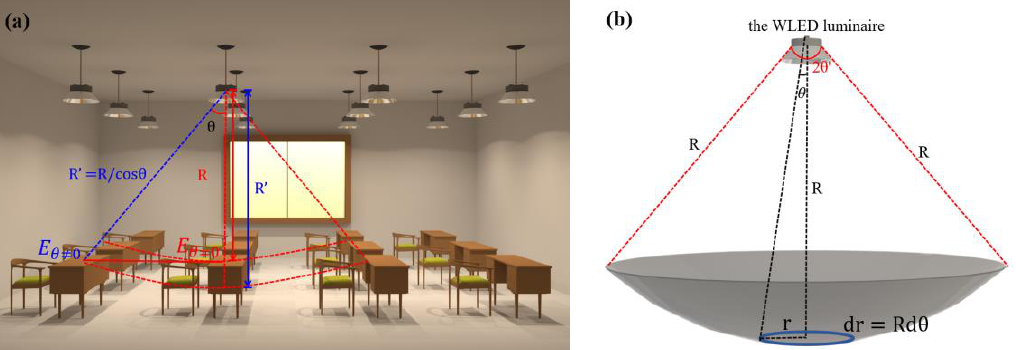
Figure 3. ( a ) Illumination scenario of the WLED matrix in the indoor area. ( b ) Schematic diagram of the transmission-distance-based optical distribution of a WLED luminaire.